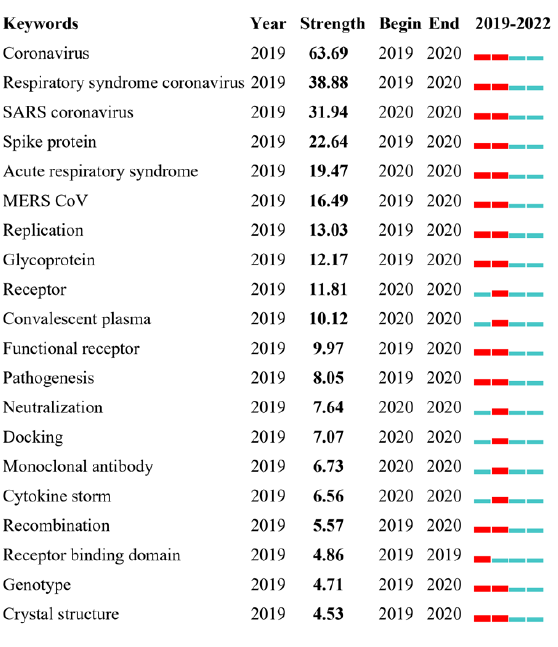
Figure 8. Keywords with the strongest citation bursts in publications on COVID-19 vaccine research, by CiteSpace analysis. The red lines in the diagram are heat bars, representing the time period with the strongest citation bursts.